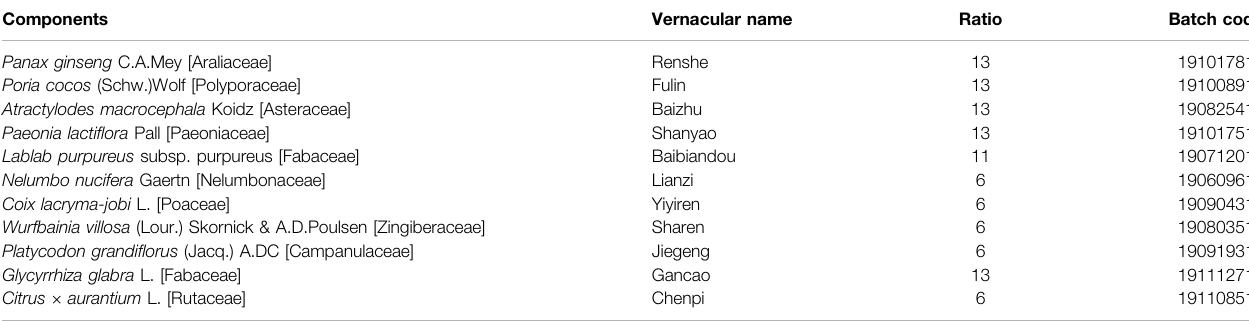
TABLE 1 | Recipe of SBP decoction.